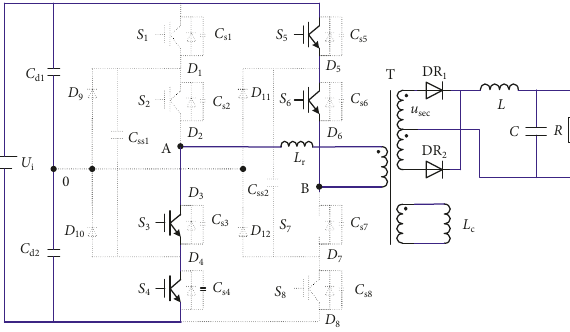
Figure 14: Equivalent circuit of mode